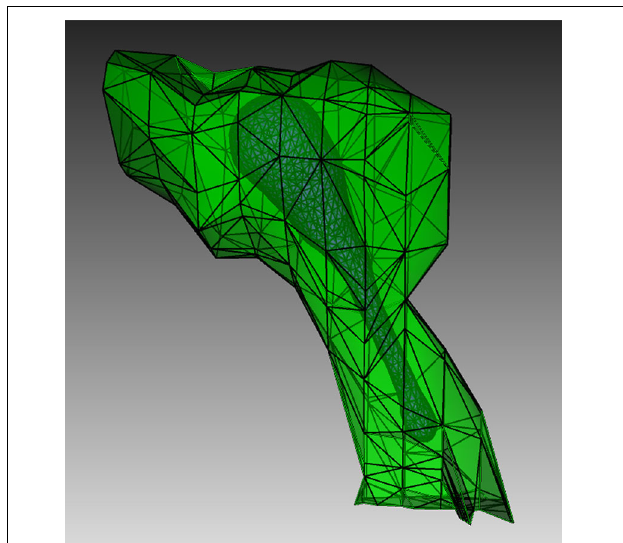
FIGURE 4 | Geometry for the IP 3 R model simulation. Green: A spine morphology extracted from EM spiny dendrite reconstruction. Purple: triangular surface that divides the spine into ER and cytosol.